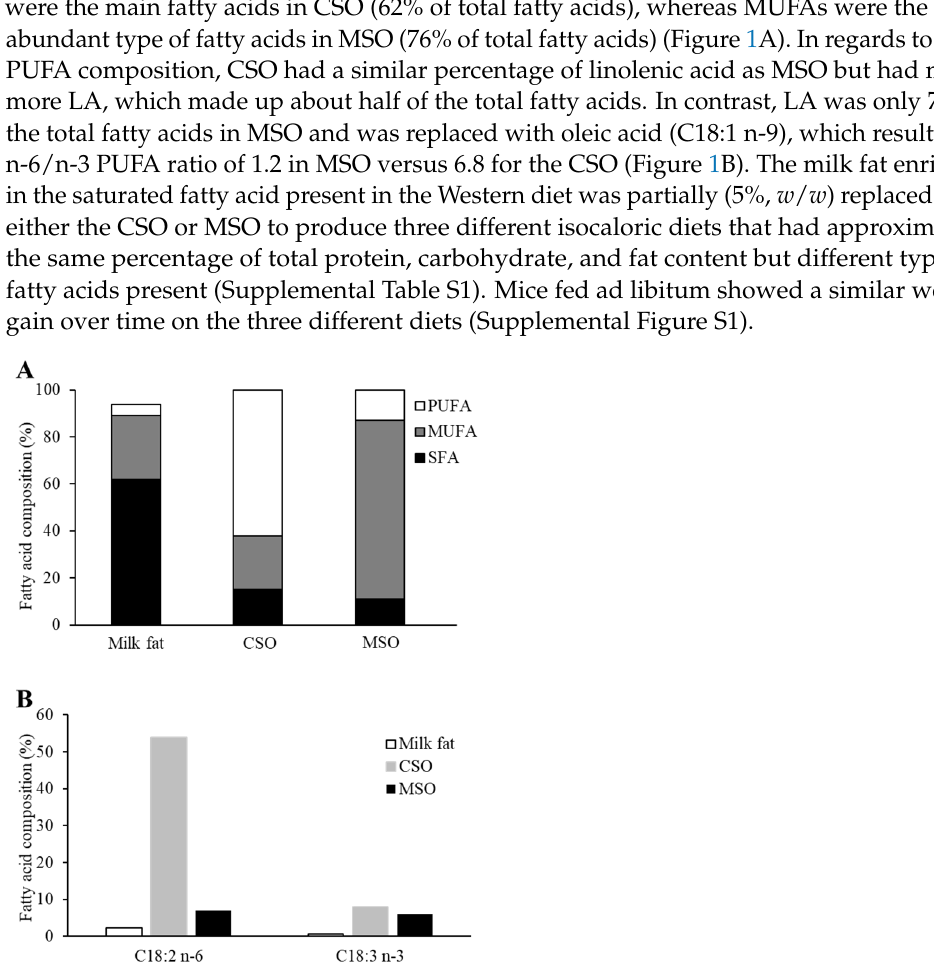
Figure 1. Fatty acid composition of dietary oils incorporated into mouse diets. ( A ) Comparison of total SFA, MUFA and PUFA in the milkfat in Western diet, CSO, and MSO. ( B ) Comparison of PUFA linoleic acid (C18:2 n-6) and linolenic acid (C18:3 n-3) in the milkfat, CSO, and MSO. SFA: saturated